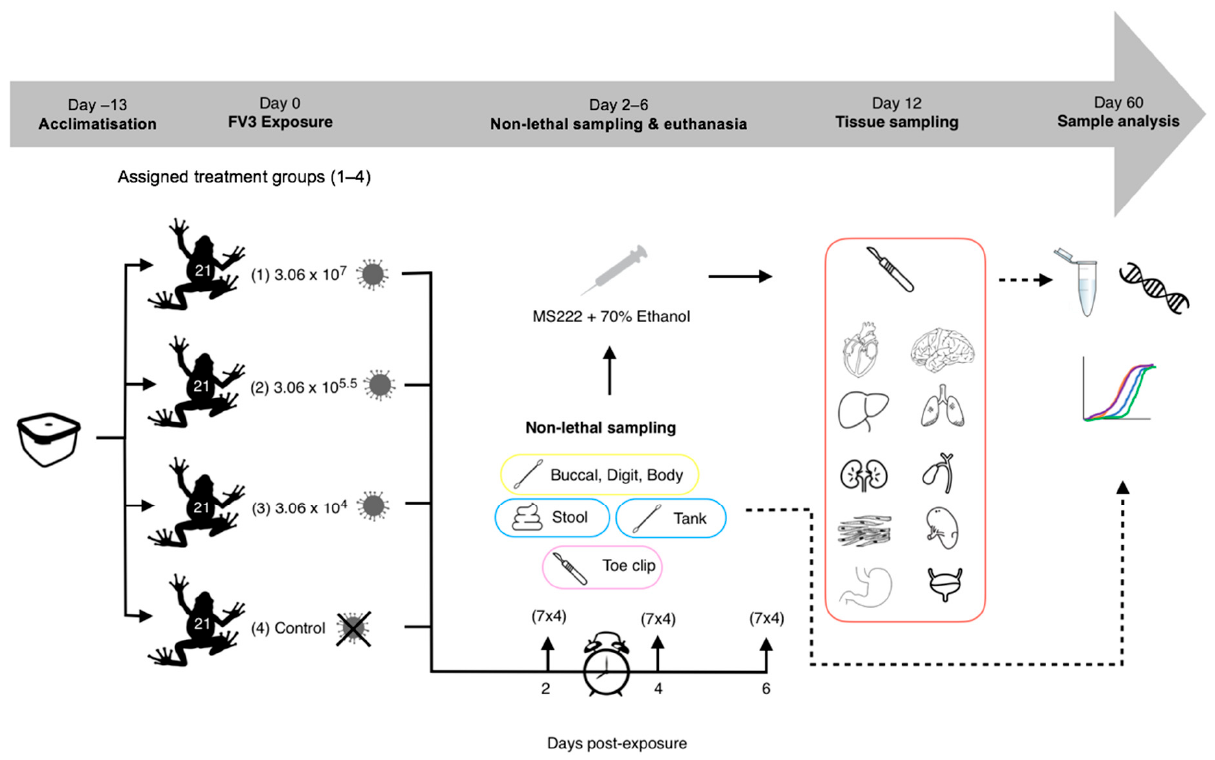
Figure 1. Experimental 1 workflow (experimental design and post-experimental processing).